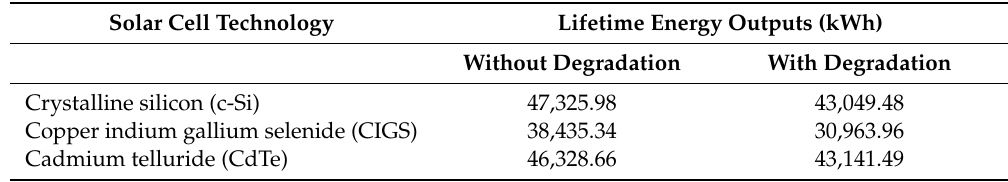
Table 9. Lifetime energy outputs from the 3-L SPVT using the c-Si, CIGS, and CdTe solar PV leaves. Solar Cell